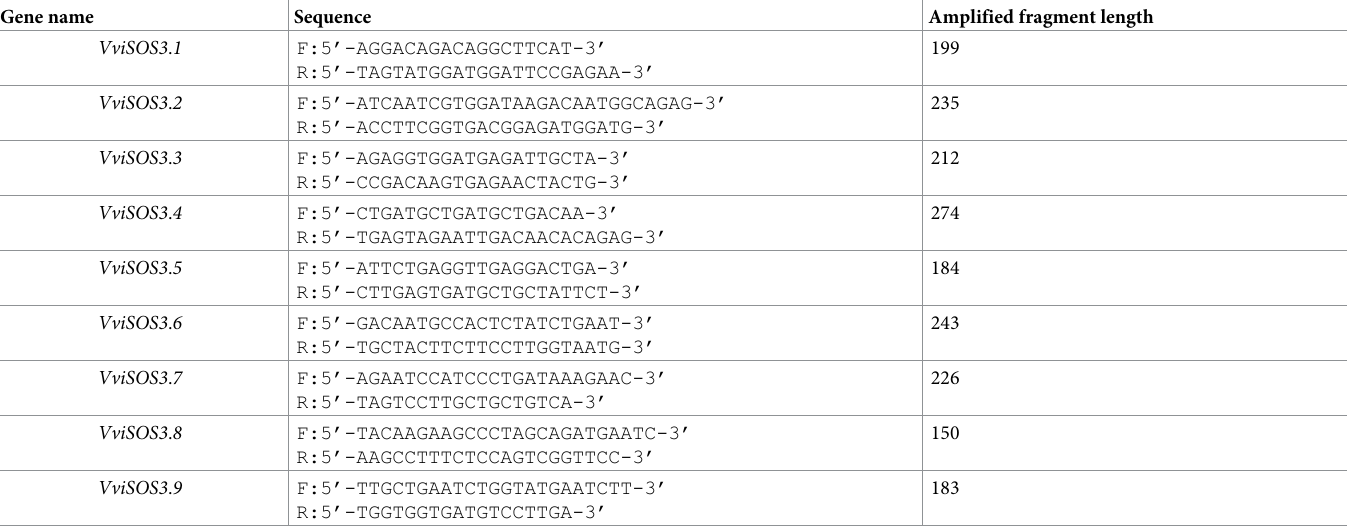
Table 1. Sequence of primers and PCR amplified products. Gene